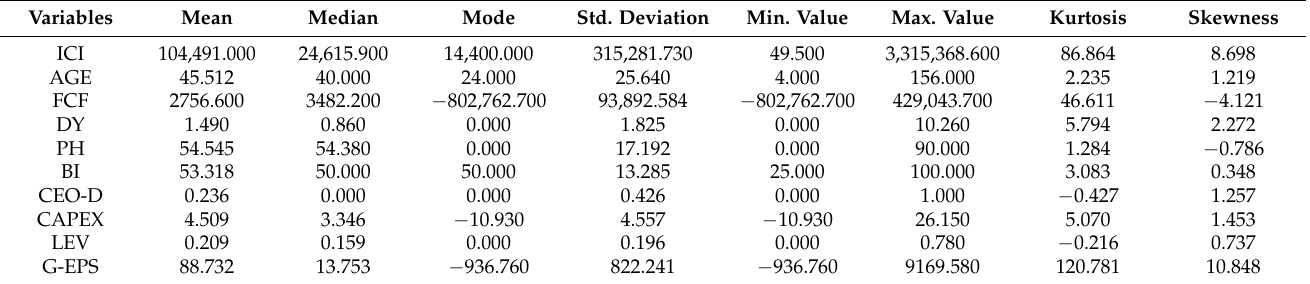
Table 3. Descriptive Statistics for the sample during the year 2015–2019.